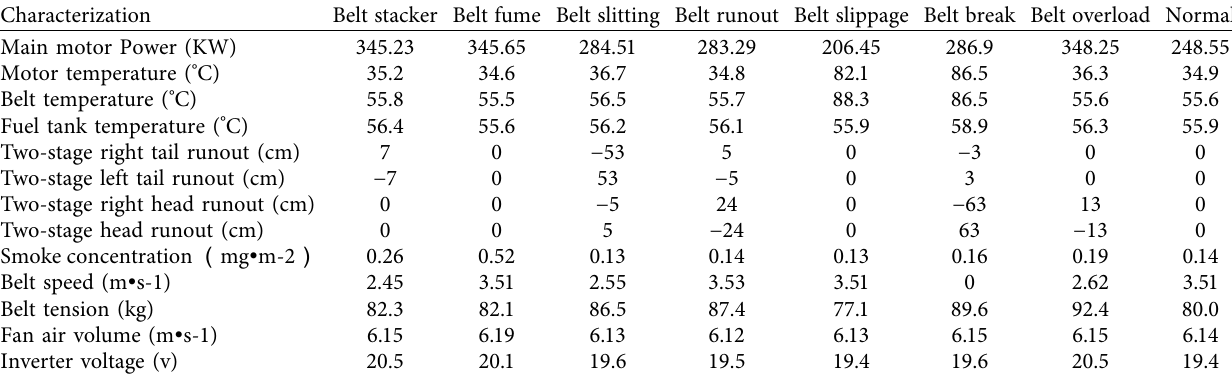
Table 1: Health characteristics of coal mine belt conveyors in operating condition.